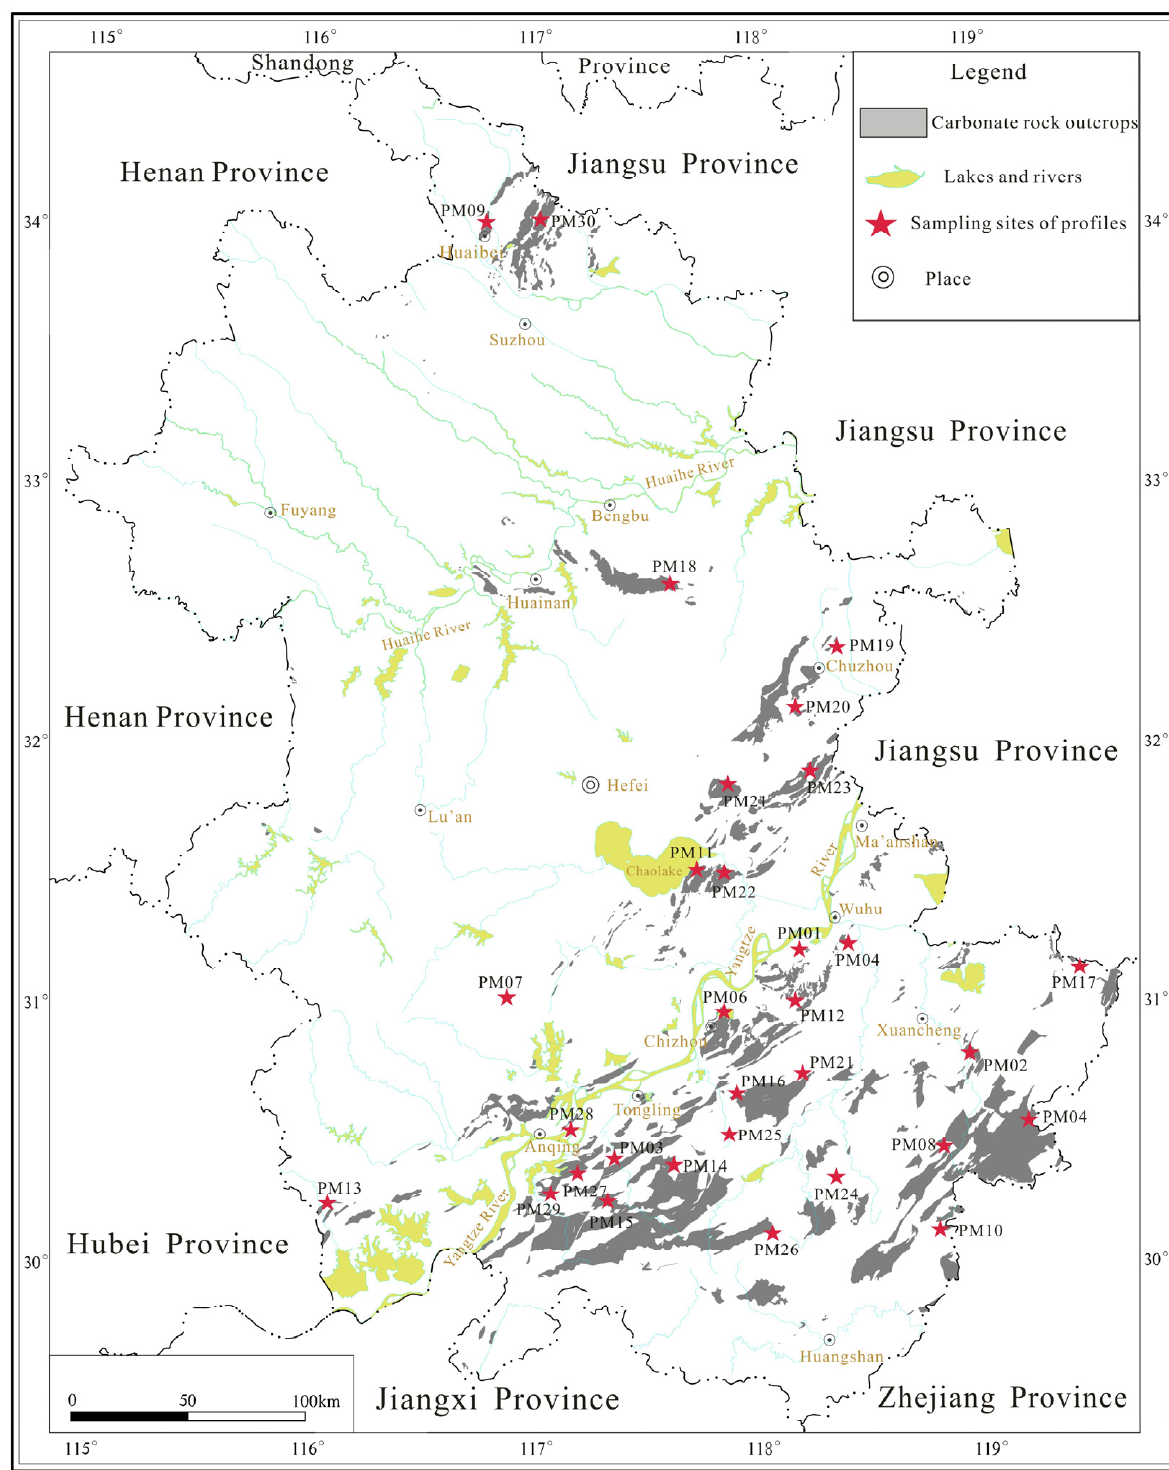
Figure 1. Schematic showing the sampling sites in the study area.